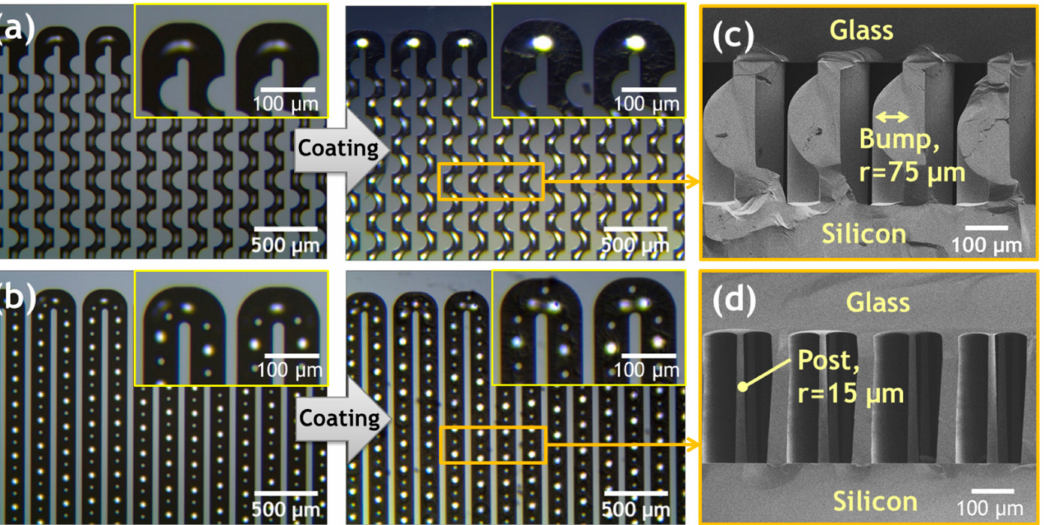
Figure 3. Top-view optical micrographs of the µ -GC columns before and after an OV-1 thin-film stationary phase was coated onto ( a ) the bump structure µ -GC column and ( b ) the post structure µ -GC column; ( c ) cross-sectional SEM image (tilted to show the bump structures formed in the column channel) of the bump structure µ -GC column; ( d ) cross-sectional SEM image of the post structure µ -GC